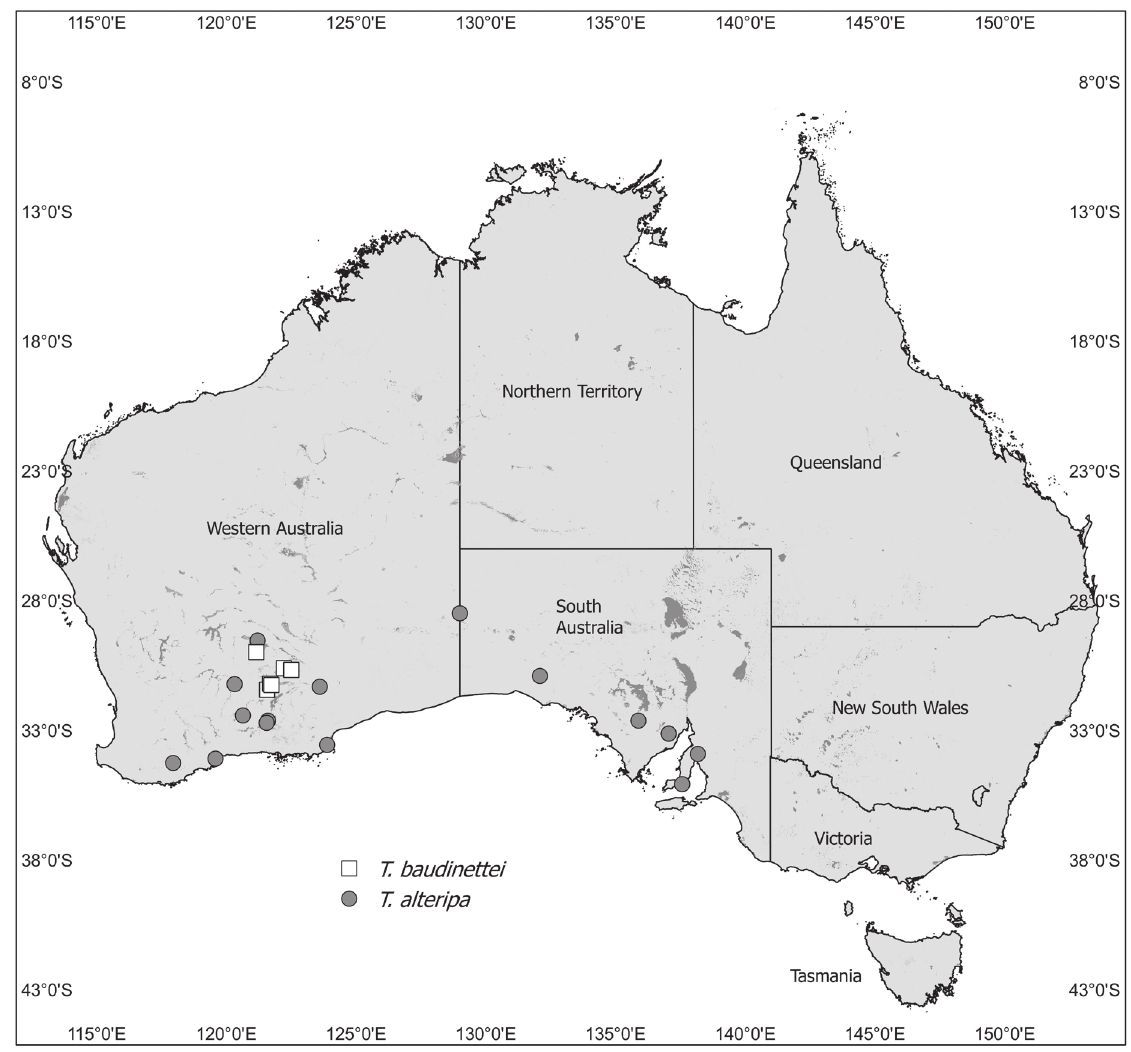
Fig. 17. Tetralycosa alteripa (McKay, 1976) and T. baudinettei sp. nov., distribution records in